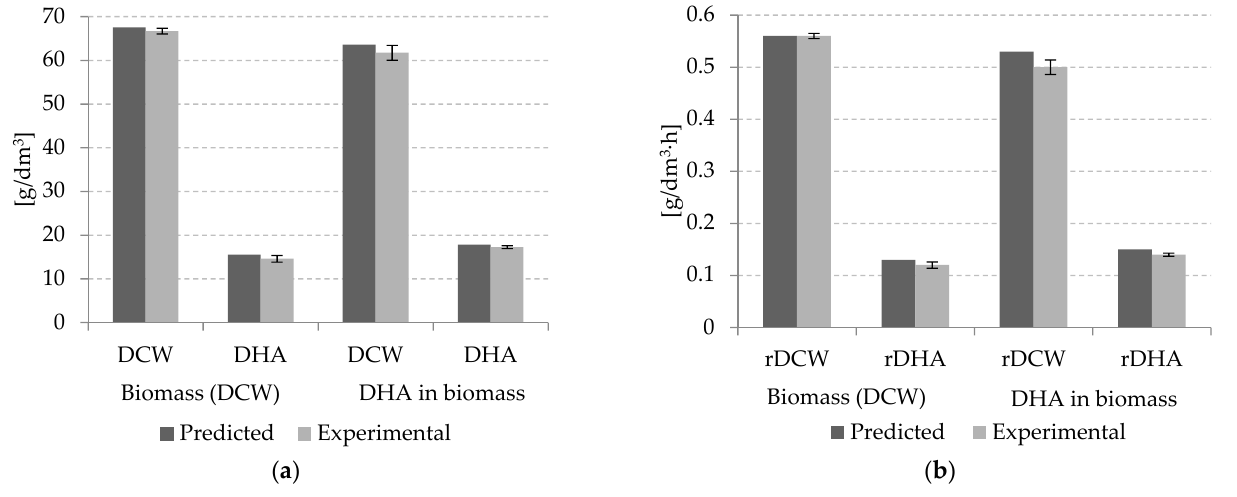
Figure 5. Comparison of ( a ) obtained levels of biomass (DCW) and DHA; and ( b ) biomass growth rate and microalgal DHA production with the parameters set using the response surface methodology and experimental data (by culture purpose).